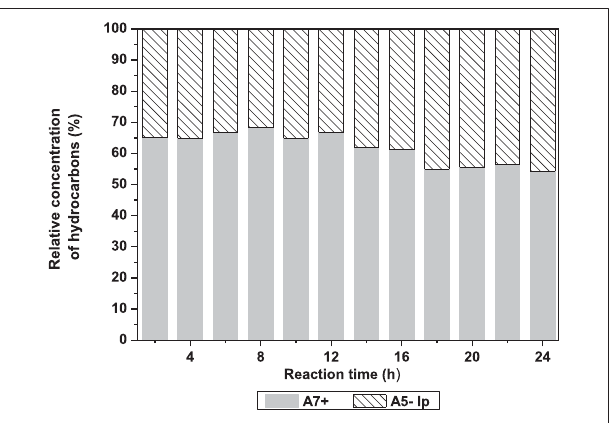
FIGURE 5 | Composition of alkanes with fi ve or fewer carbons (A 5- lp, Panel A ) and alkanes with seven or more carbons (A 7+ , Panel B ), including methyl cyclopentane and cyclohexane, over reaction time in the liquid